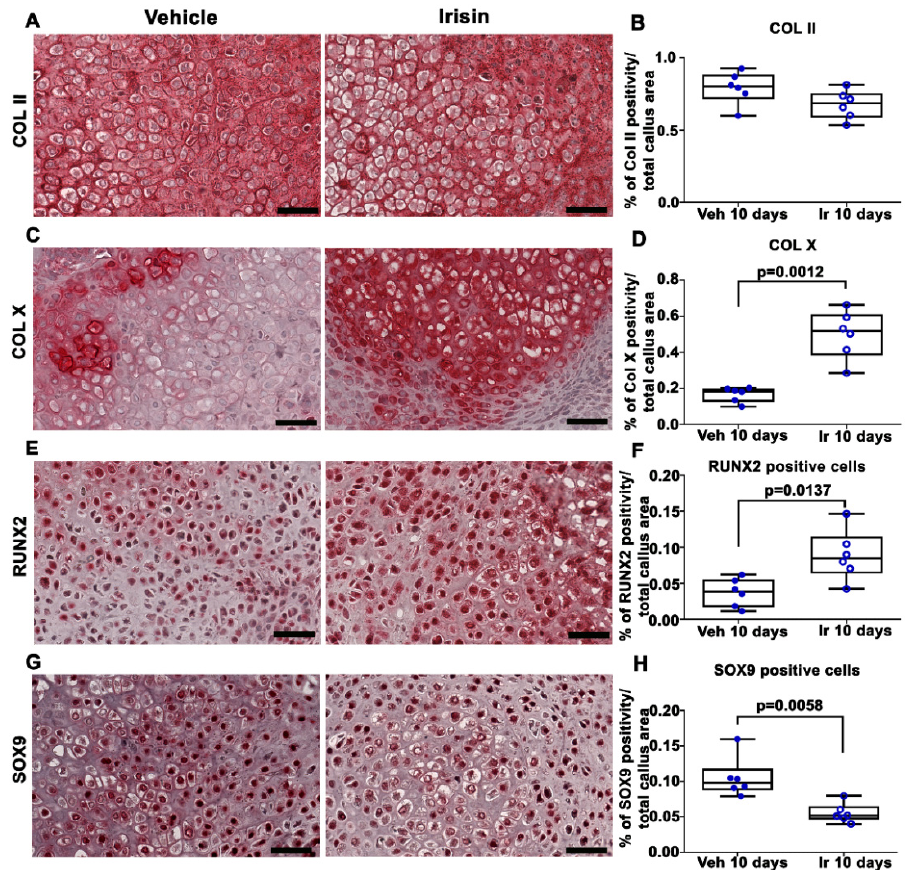
Figure 2. Representative images of ( A ) COL II, ( C ) Col X, ( E ) RUNX2 and ( G ) SOX9 immunostaining in callus sections from vehicle-treated mice ( n = 6) and irisin-treated mice ( n = 6) at 10 days post- fracture (scale bars: 20 µ m). Dot-plot graphs showing the quantification of ( B ) COL II, ( D ) COL X, ( F ) RUNX2 and ( H ) SOX9 expression. Data are presented as dot-plots with medians, from maximum to minimum, with all data points shown. The Mann–Whitney test was used to compare groups.